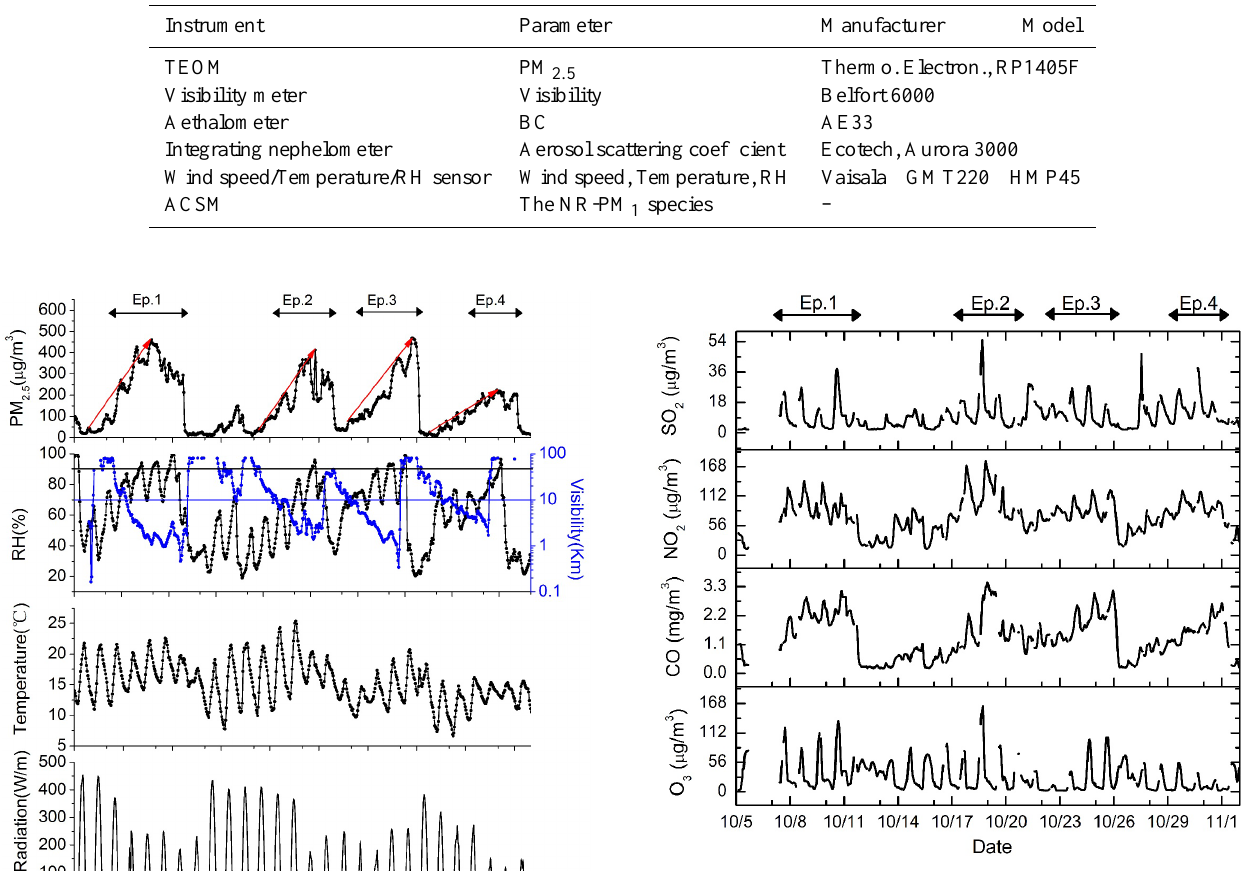
Figure 3. Time series of observed gaseous pollutants (SO 2 , NO 2 , CO, O 3 ) in Beijing from 5 October to 2 November